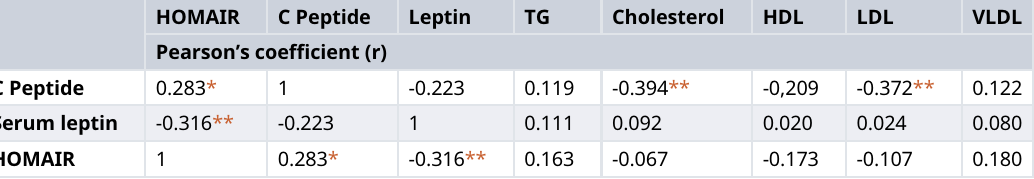
Table 5. Correlation of serum leptin, C peptide, and HOMAIR with various parameters in all subjects.